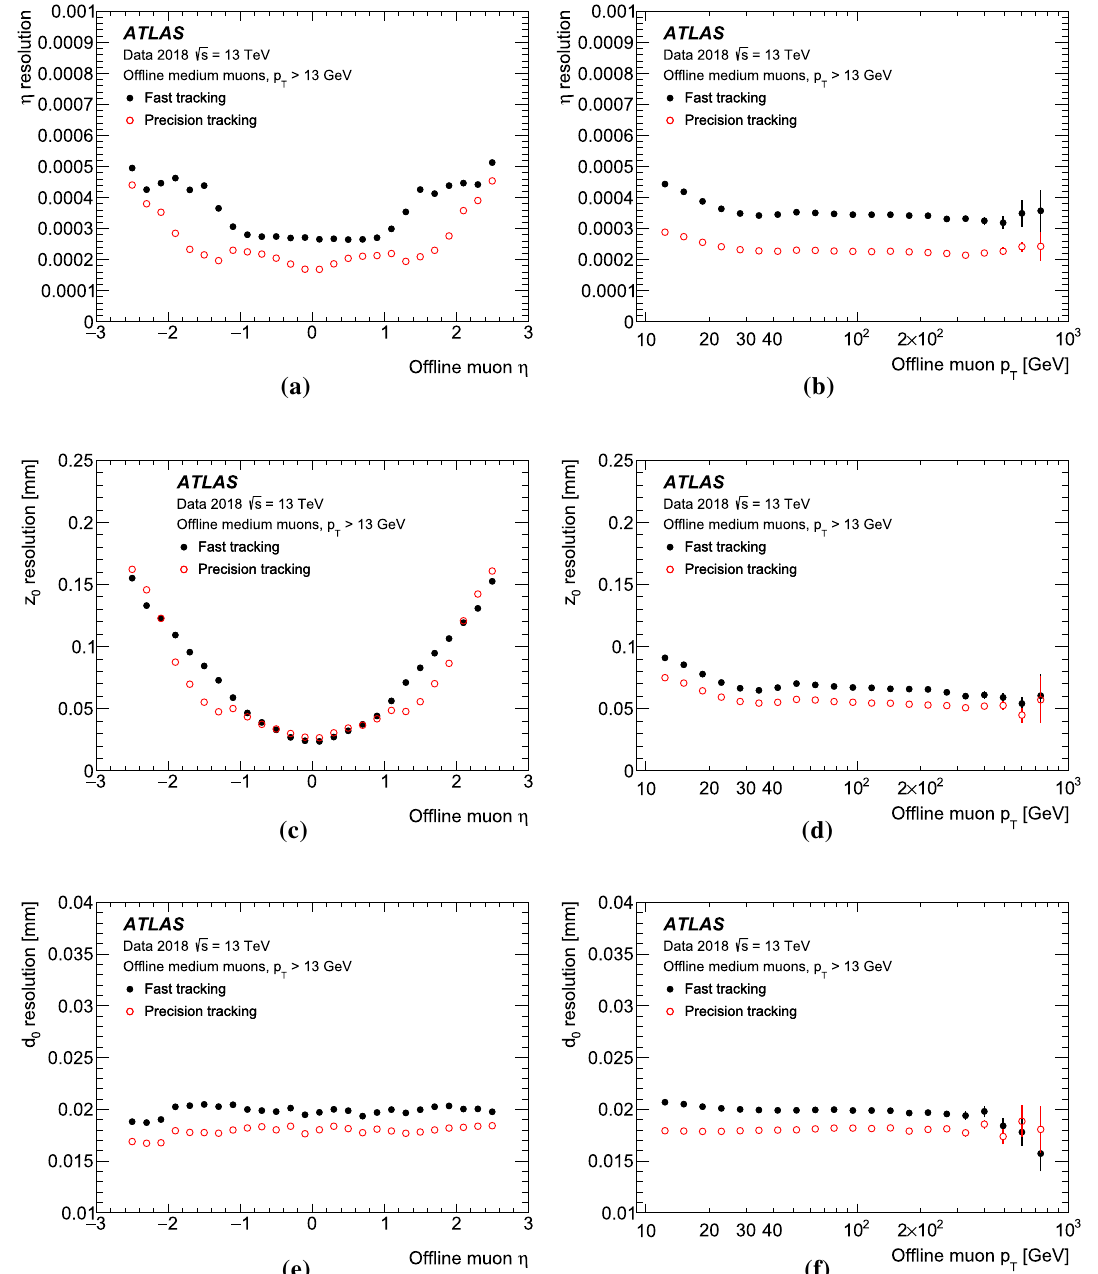
Fig. 22 The resolution in the pseudorapidity and inverse transverse momentum as a function of offline track pseudorapidity and transverse momentum. The resolutions are shown for muons selected with the